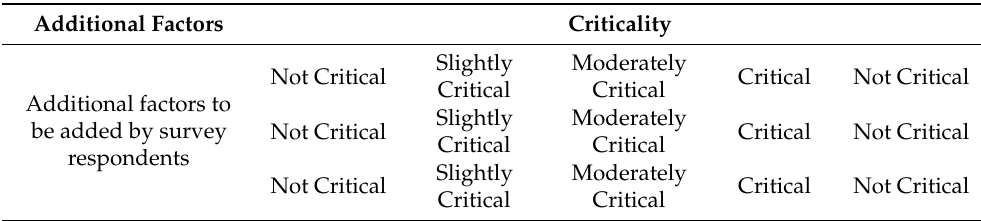
Table A2. Please indicate and rate any additional factors affecting workplace well-being in building construction